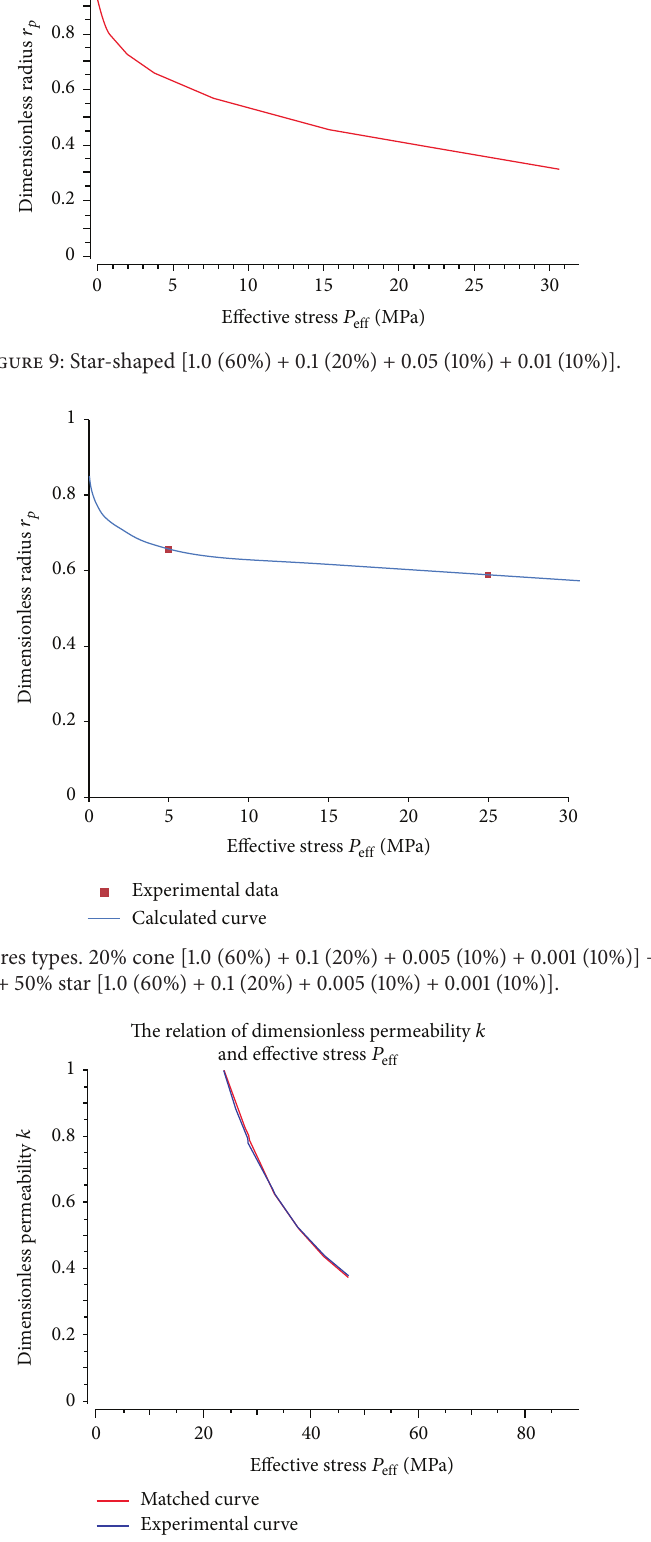
Figure 11: Comparison diagram of the program calculation curve and experiment data. 50% oval [0.01 (60%) + 0.005 (30%) + 0.0012 (10%)] + 50% star [0.1 (27%) + 0.005 (36%) + 0.0012